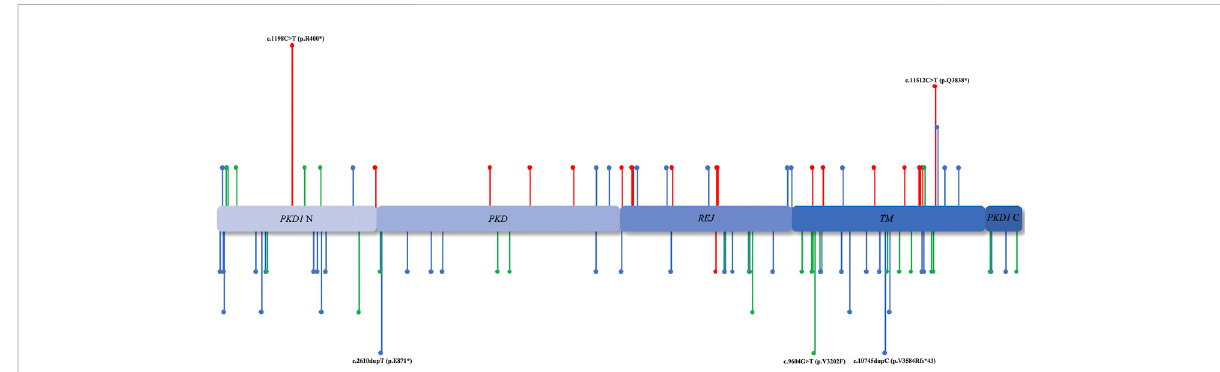
FIGURE 3 Mutation region. The distribution of PKD1/PKD2 mutation sites in various domains. The unreported mutation sites are annotated below, whereas those reported previously are annotated above. The red lines represent ACMG I, the blue lines represent ACMG II, and the green lines represent ACMG